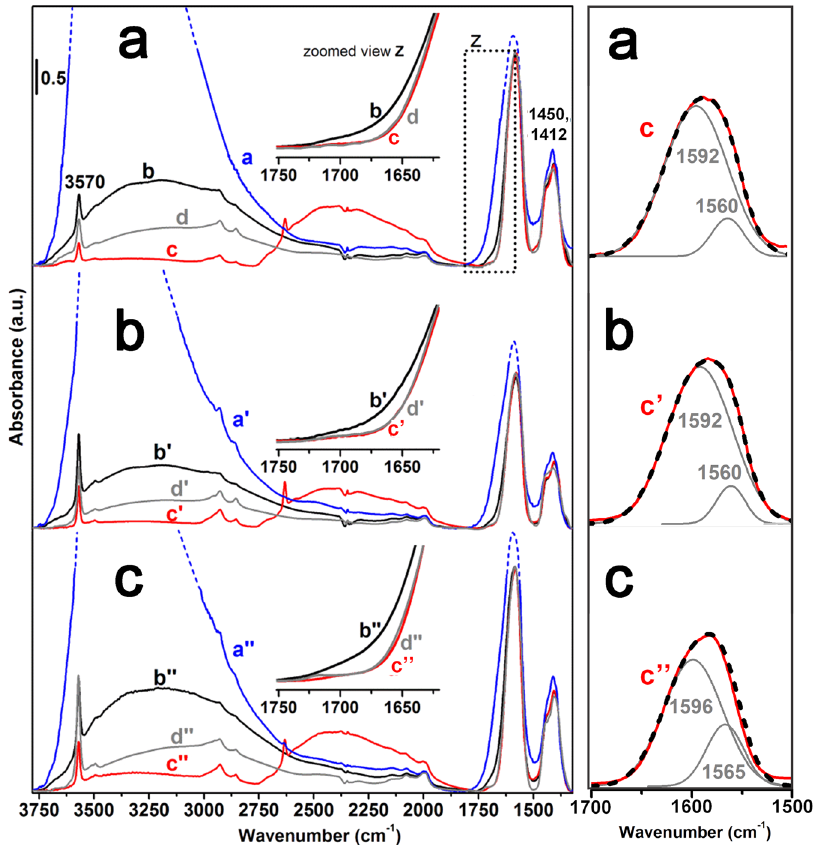
Figure 3. IR spectra of ( a ) Cit–HA–4 h, ( b ) Cit–HA–24 h; ( c ) Cit–HA–96 h. Left panel, curve labelling in left panel is: ( a,a ’ ,a ”) in contact with H 2 O vapor at 20 mbar; ( b,b ’ ,b ”) after 60 min outgassing at b.t.; ( c,c ’ ,c ”) after exchange with D 2 O and subsequent 60 min outgassing at b.t.; ( d,d ,’ d ”) after back exchange with H 2 O and subsequent 120 min outgassing at 433 K. Inset: zoomed view of the 1750–1600 cm − 1 range. Right panel: zoomed view of the 1700–1500 cm − 1 range, showing the experimental ν COO − asym band in curves c,c ’ ,c ” (thus without any δ H 2 O contribution) and related fitting (dashed black curve = sum of individual components, in grey).